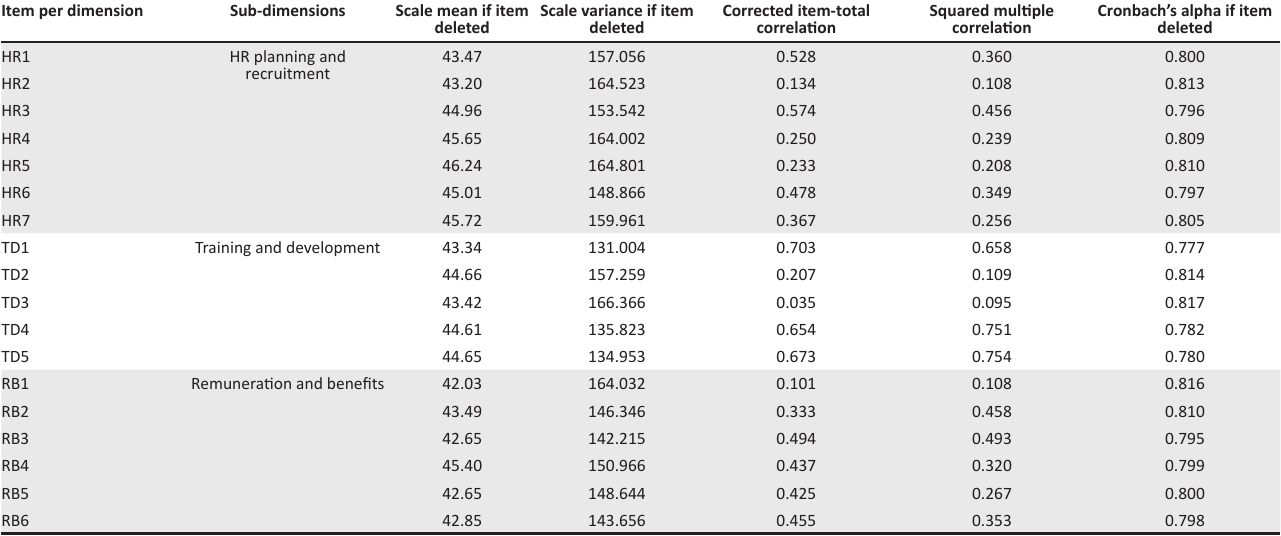
TABLE 9: Iterative item reliability analysis: Human capital disclosure. Item per